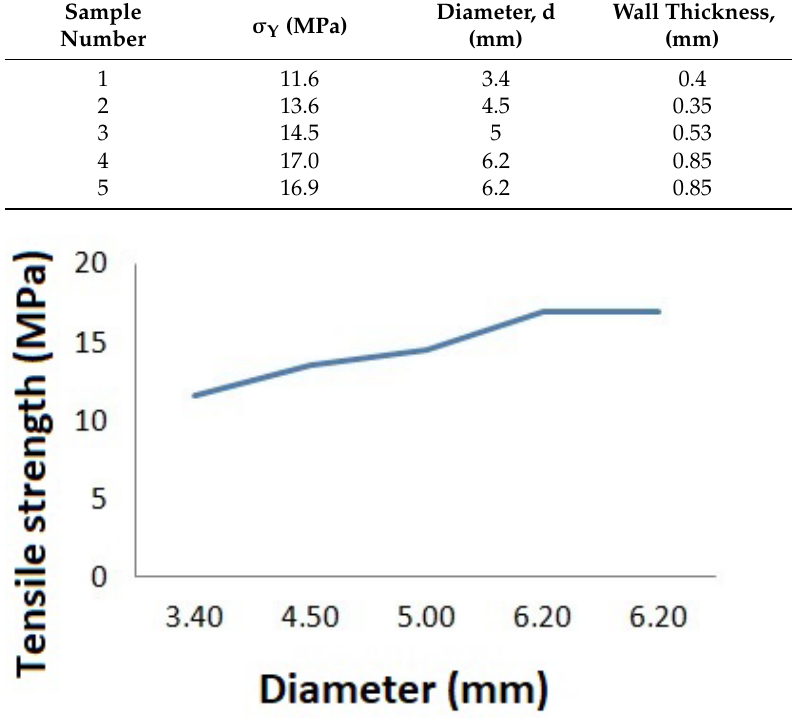
Figure 4. Plot of change in ultimate strength with specimen diameter. Table 4. Values of hyperelastic models for two